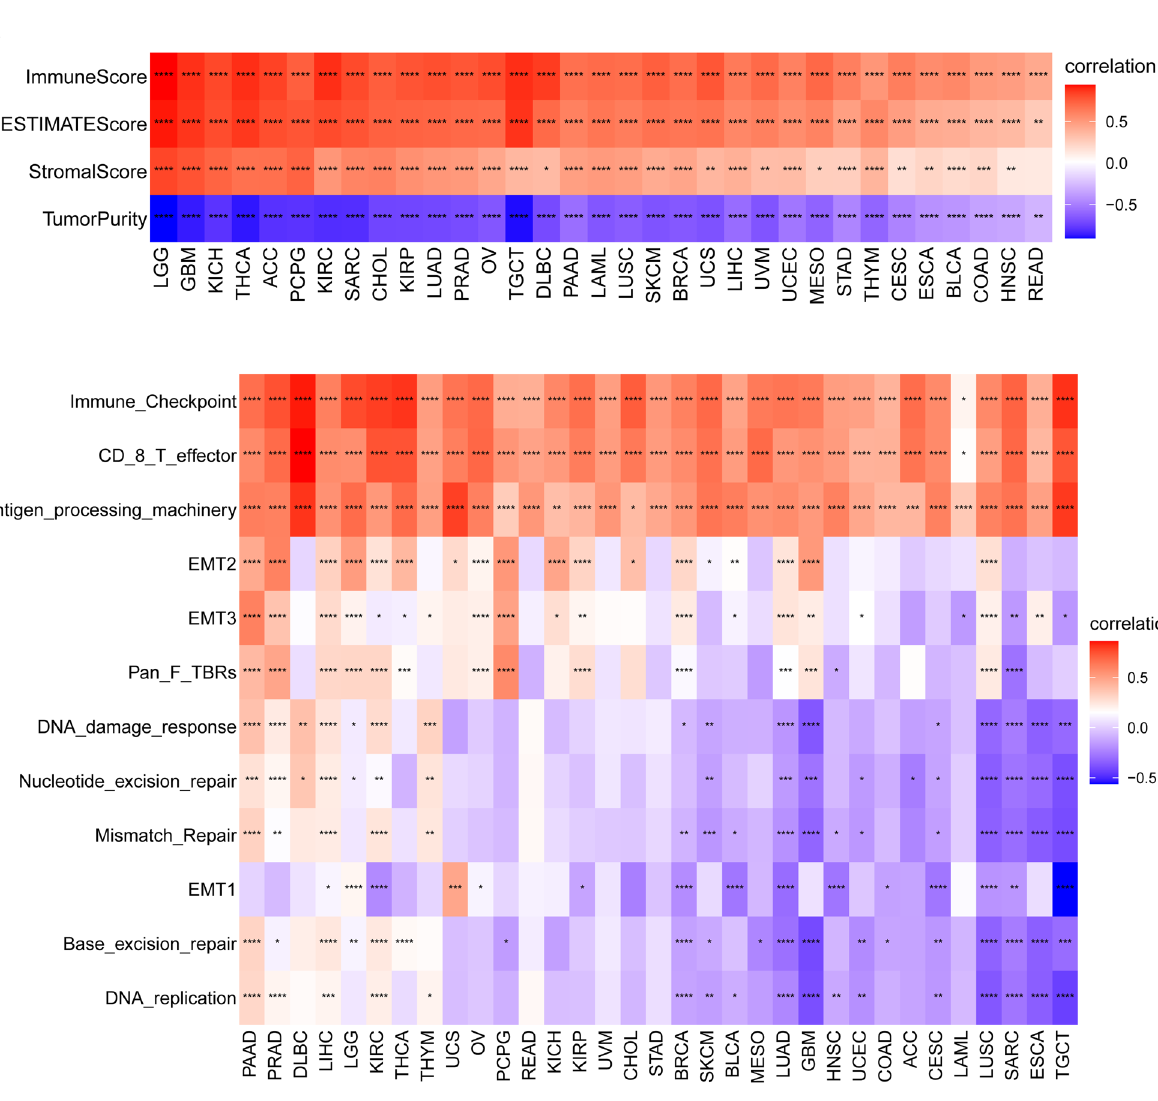
Figure 9. TME analysis of PANoptosis score in pan-cancer. ( A ) Heatmap shows the correlation between PANoptosis score and ImmuneScore, ESTIMATEScore, StromalScore, and TumorPurity. ( B ) Heatmap shows the correlation between PANoptosis score and TME-related pathways. * P < 0.05, ** P < 0.01, *** P < 0.001, **** P <